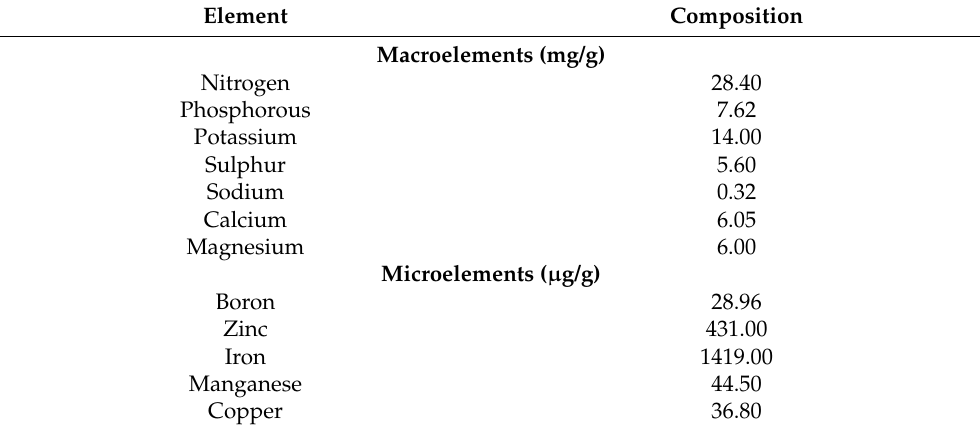
Table 2. Elemental composition of Balanites roxburghii seed